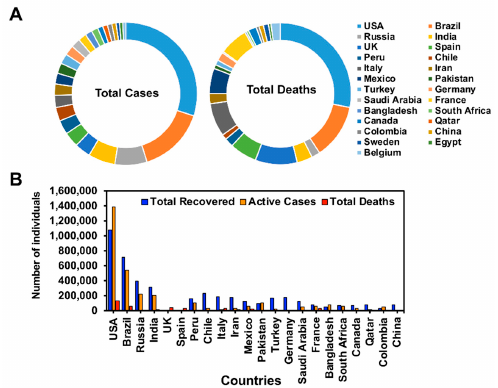
Figure 1. Total number of COVID-19 cases worldwide (25 countries on the list). Total confirmed cases and total deaths based on the countries ( A ), graphical representation of total recovered active cases, and fatalities based on the top 25 countries ( B ).